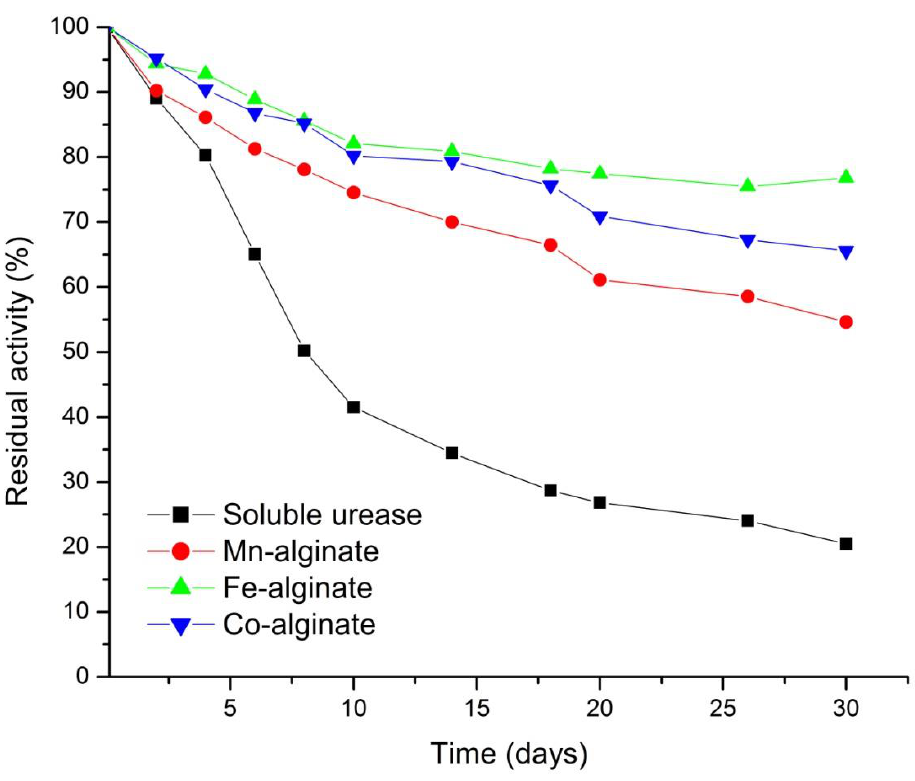
Figure 6. Variation of percent residual activity of immobilized enzyme with time for alginate nanogels cross-linked with Mn 2+ , Fe 3+ , and Co 2+ . Table 6. Determination of urea in blood serum samples using the urease-encapsulated Fe–alginate nanogels and a comparative spectrophotometric method used in clinical laboratories.